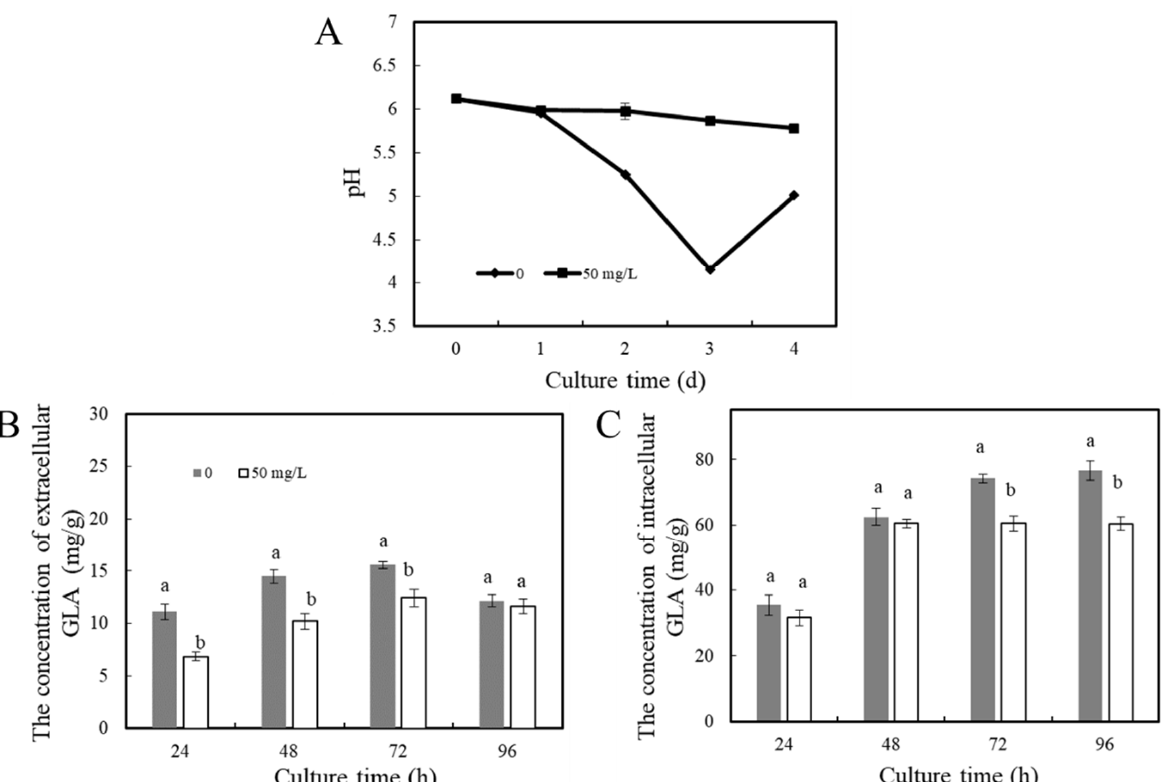
Figure 3. Effect of ε -PL treatment on the acid production of P. expansum in vitro. ( A ) pH change of the PDB supernatant during the growth of P. expansum , ( B ) the intracellular gluconic acid content of mycelia during the growth of P. expansum , and ( C ) extracellular gluconic acid content during the growth of P. expansum (GLA = gluconic acid). The data provided are the average of three repetitions. The vertical bar represents the standard deviation. According to Tukey’s test, different letters indicate significant differences ( p < 0.05).